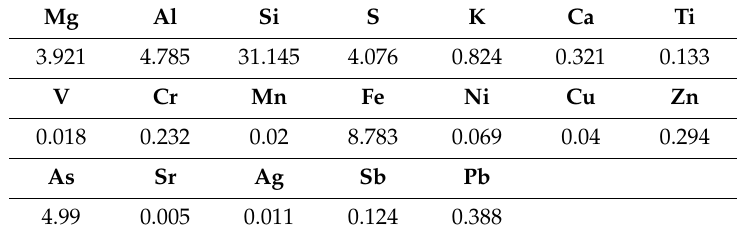
Table 2. Element analysis of samples by XRF (mass fraction, %).